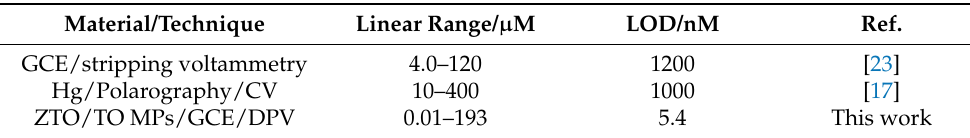
Table 1. Comparison of the analytical performance of ZTO/TO MPs/GCE in the electrochemical detection of SCZ with other